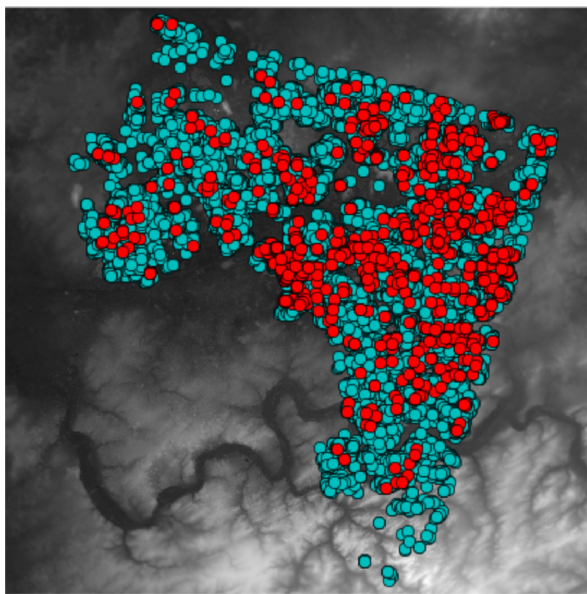
Figure 2: Distribution of households in test